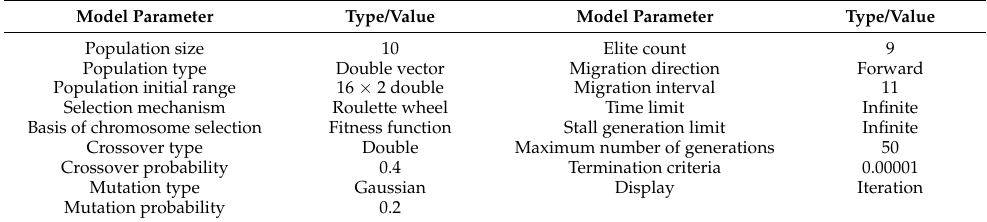
Table 3. Parameters of reconstructed NDVI model based on GA-ANN.